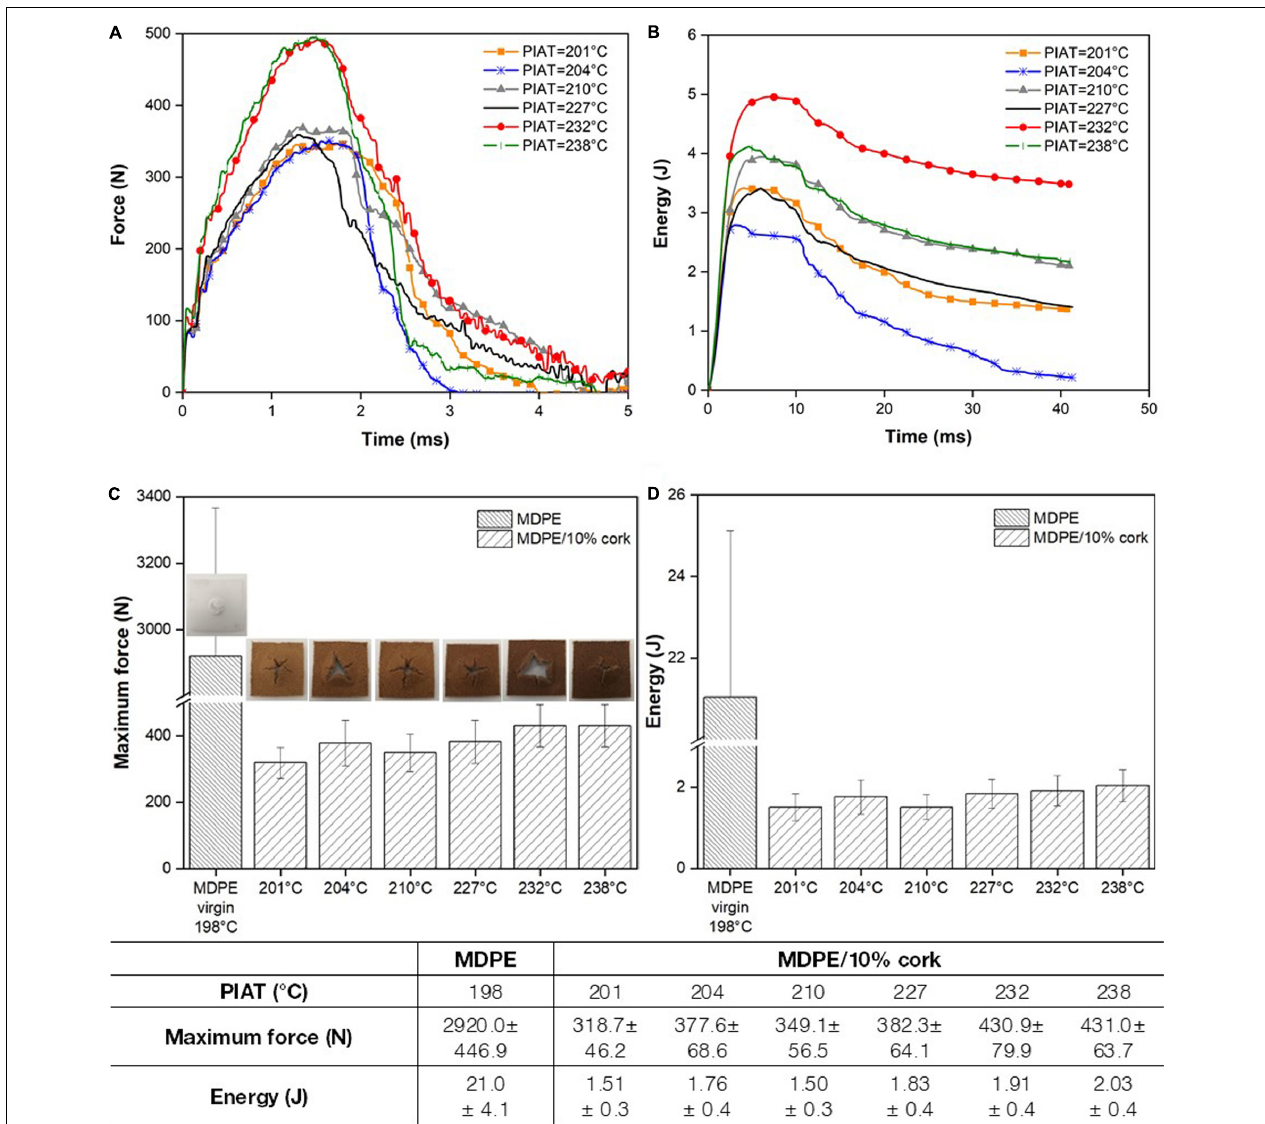
FIGURE 10 | Effect of PIAT on the impact behavior of MDPE and MDPE/10% cork parts. (A) Force over time; (B) Energy over time; (C) Maximum force as a function of PIAT and related samples fracture surfaces; (D) Energy at maximum force as a function of PIAT. TABLE 4 | Density of the